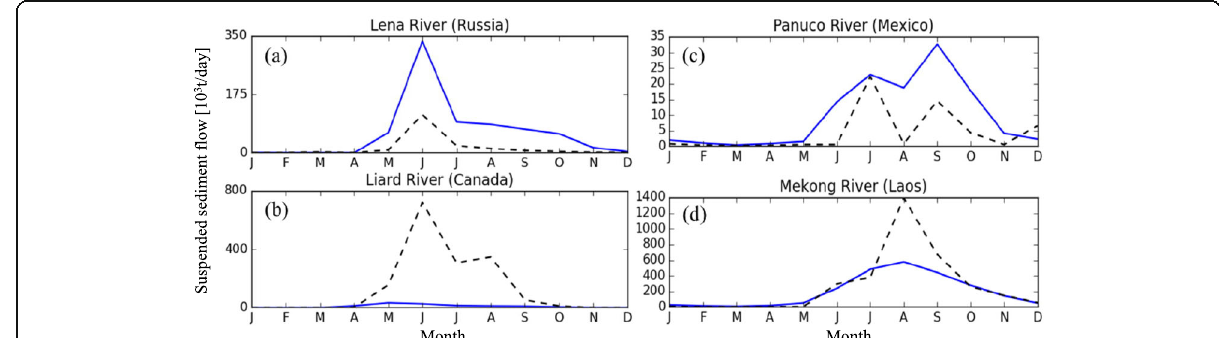
Fig. 6 Averaged monthly suspended sediment flow [10 3 tons/day]. a Lena River, b Liard River, c Panuco River, and d Mekong River. Solid blue and dashed black lines indicate CTL simulation and observation data,